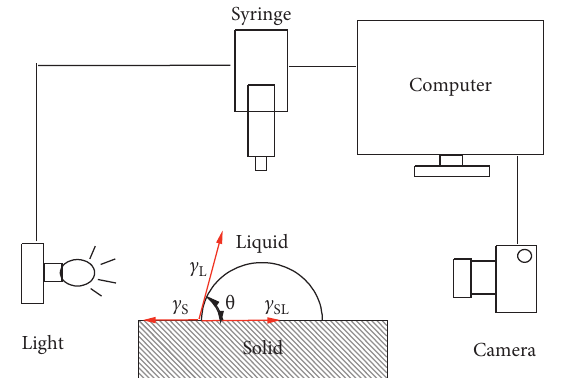
Figure 2: Schematic of contact angle